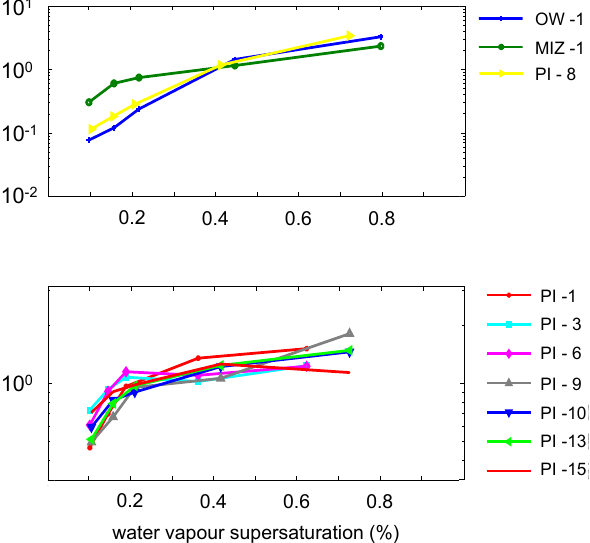
Figure 6. Variation in CCNC as a function of water vapour SS (as in Fig. 5) normalized to the average CCNC value for the duration of the impactor samples.